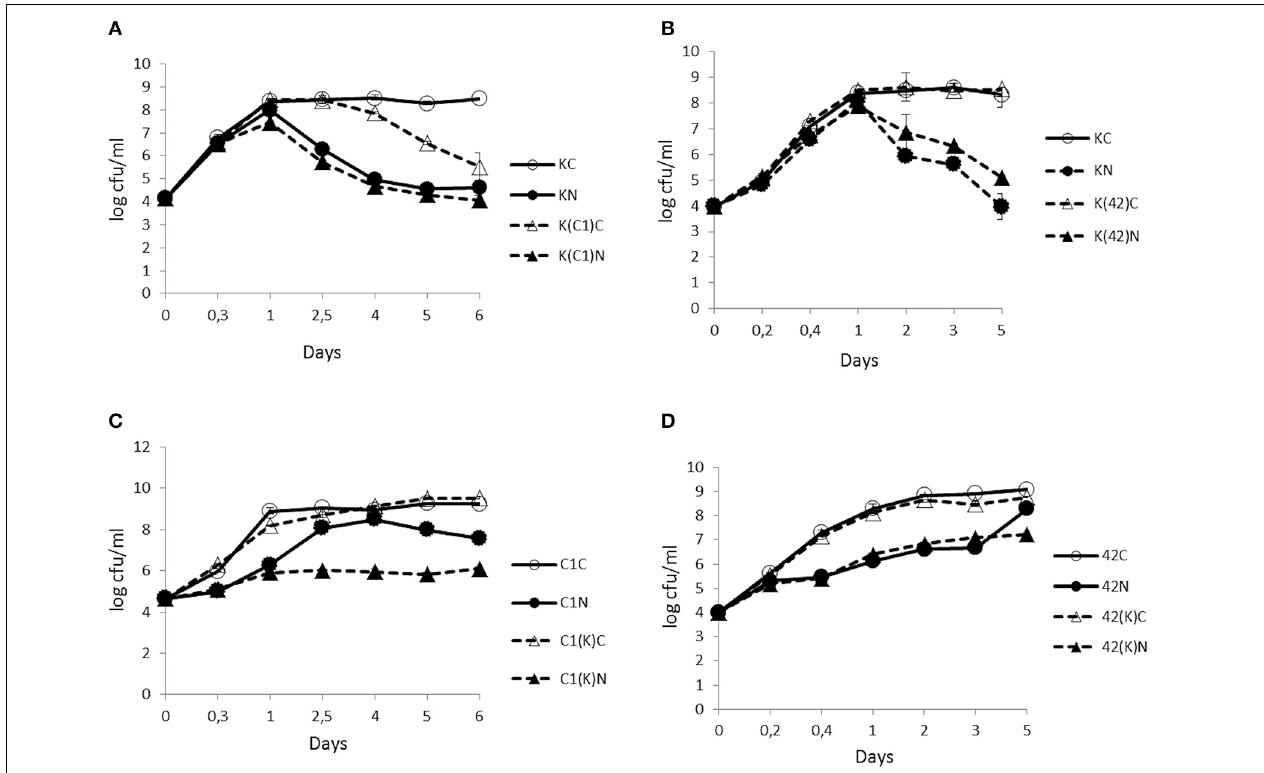
K(C1)N, KBAB4 grown in the presence of C1 flushed with N 2 ; K(42)C, KBAB4 grown in the presence of LMG 2342 T as control; K(42)N, KBAB4 grown in the presence of LMG 2342 T flushed with N 2 . (C) C1C, monoculture of the raw milk isolate C1 as control; C1N, monoculture of the raw milk isolate C1 flushed with N 2 ; C1(K)C, C1 grown in the presence of KBAB4 as control; C1(K)N, C1 grown in the presence of KBAB4 flushed with N 2 . ( D) 42C, monoculture of LMG 2342 T as control; 42N, monoculture of LMG 2342 T flushed with N 2 ; 42(K)C, LMG 2342 T grown in the presence of KBAB4 as control; 42(K)N, LMG 2342 T grown in the presence of KBAB4 flushed with N 2